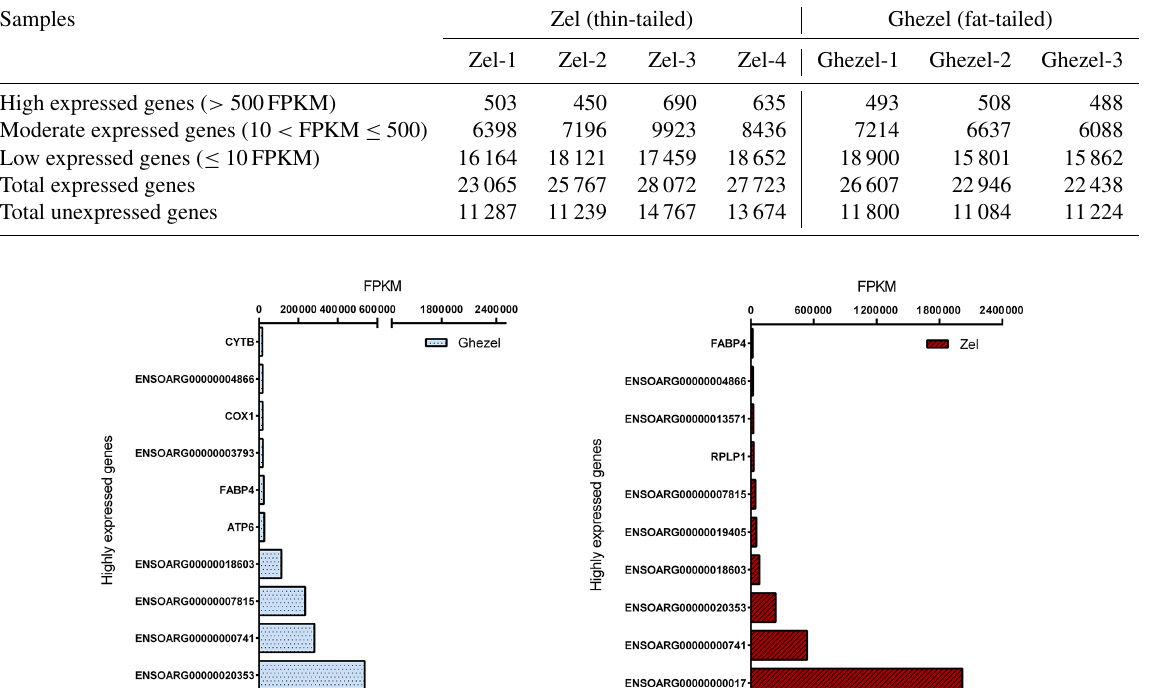
Figure 2. Top 10 highly expressed genes in adipose tissue of Ghezel (fat-tailed) and Zel (thin-tailed) breeds based on FPKM value.